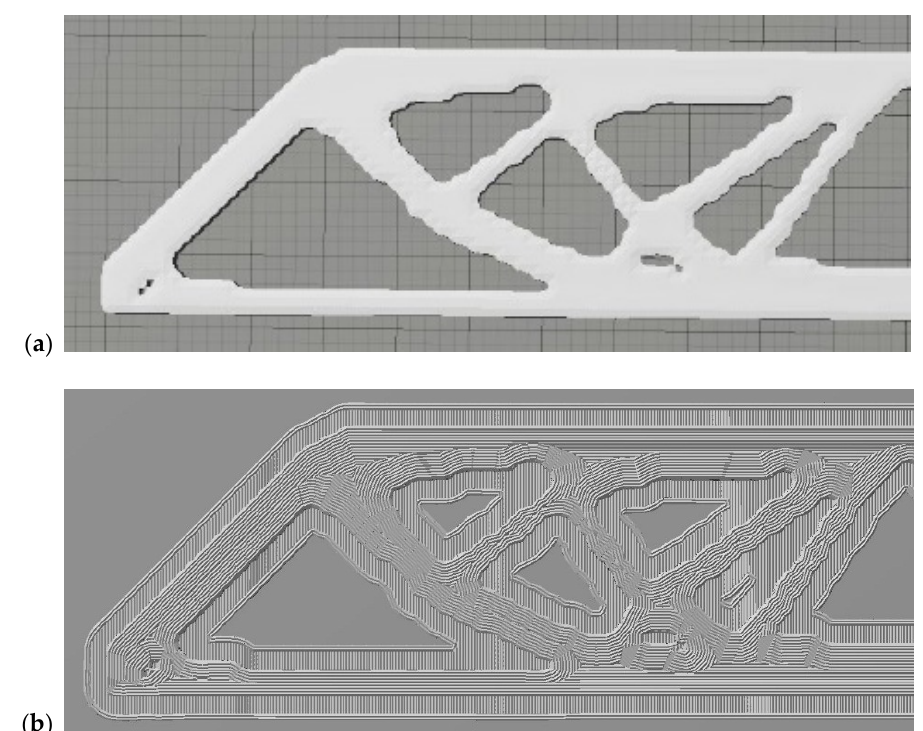
Figure 6. CFAO optimized MBB print data (left half only) of the optimized density and fiber angle distribution (5400 element model) in Figure 5e: ( a ) MeshMixer smoothed STL file data, and ( b ) MakerBot Desktop print bead pattern.